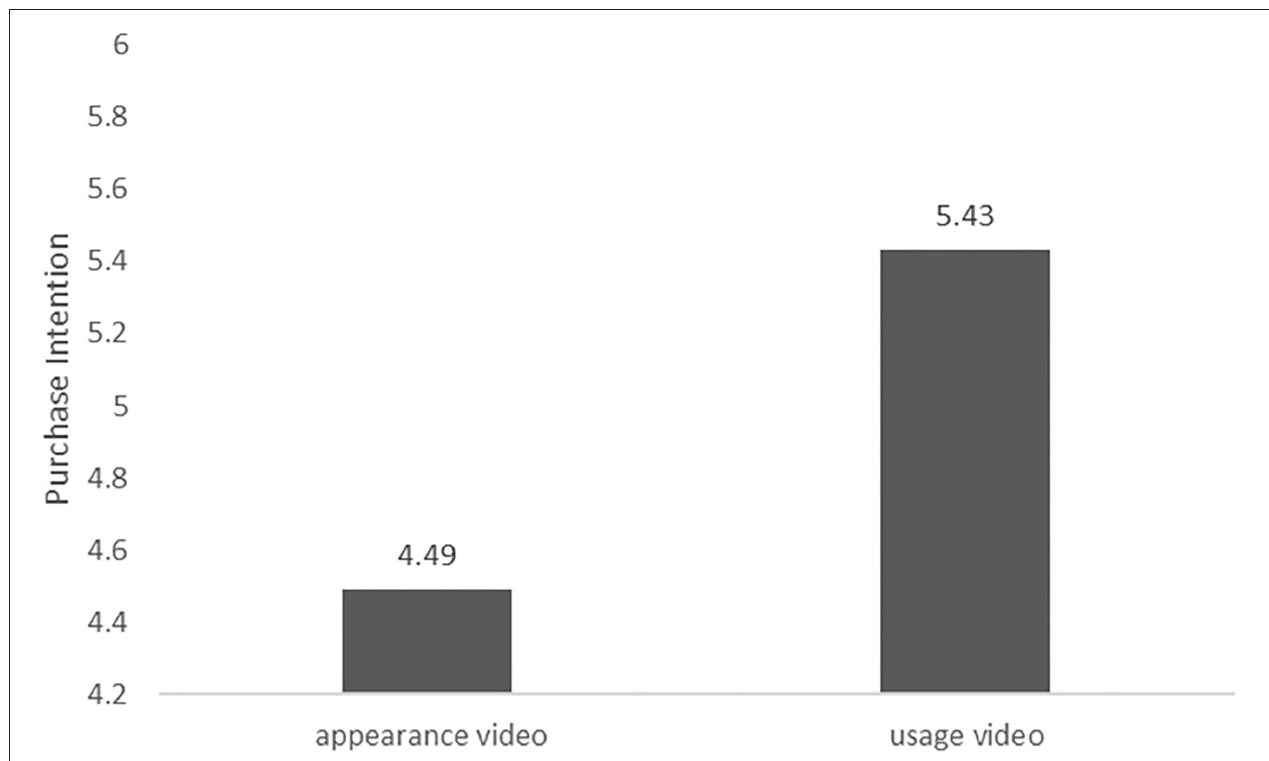
FIGURE 2 | Difference in purchase intention by the appearance video and the usage video (for a search